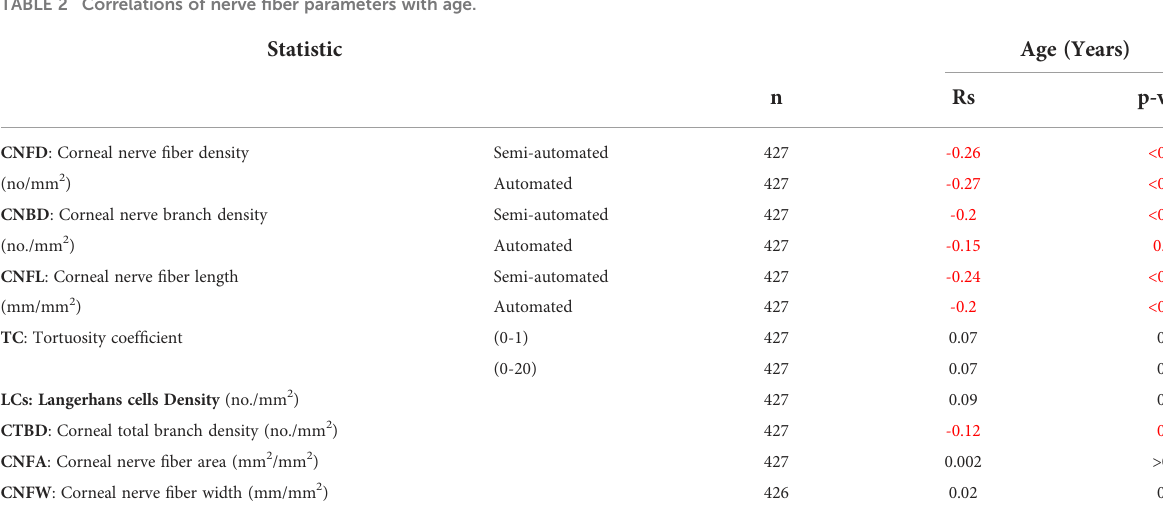
TABLE 2 Correlations of nerve fi ber parameters with age.